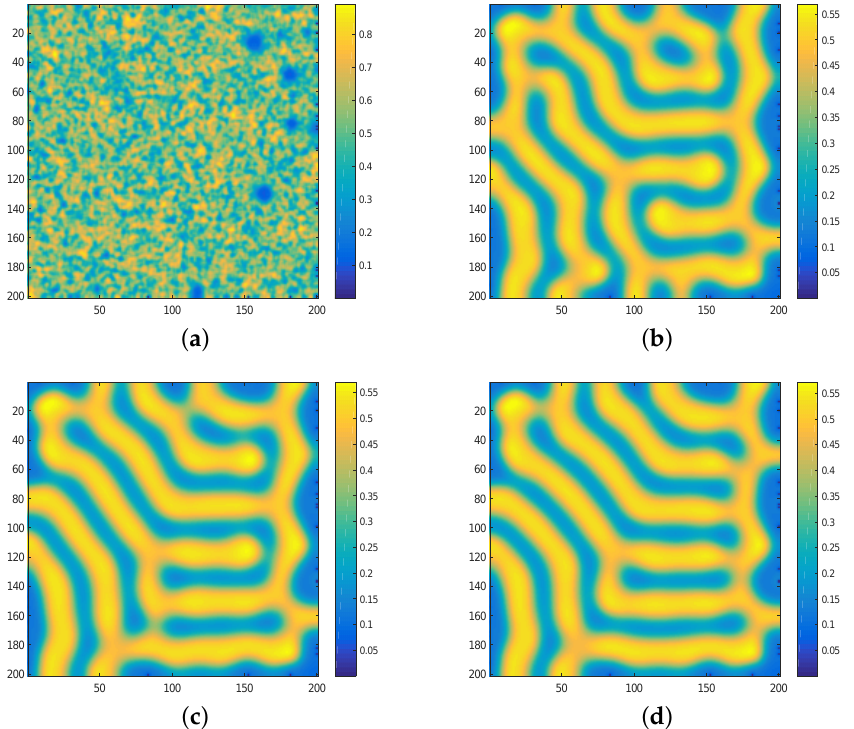
Figure 8. The patterns of u at ( a , c , d 12 , d 21 ) = ( 0.1,0.56,0.2,0.02 ) , the other parameters are fixed as in (36). Times: ( a ) t = 0, ( b ) t = 1000, ( c ) t = 3000, and ( d ) t =